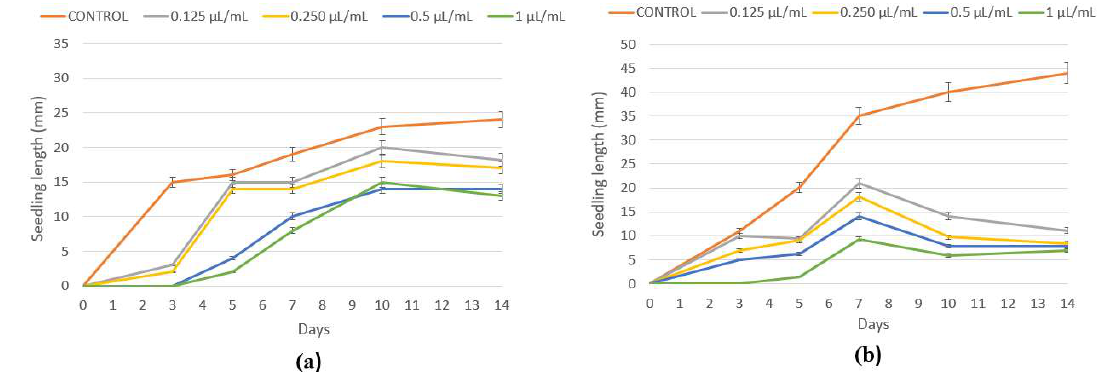
Figure 1. ( a ) P. oleracea and ( b ) E. crus-galli seedling growth with peppermint essential oil. Control and treated with peppermint essential oil at 0.125, 0.25, 0.50, and 1 µL/mL.